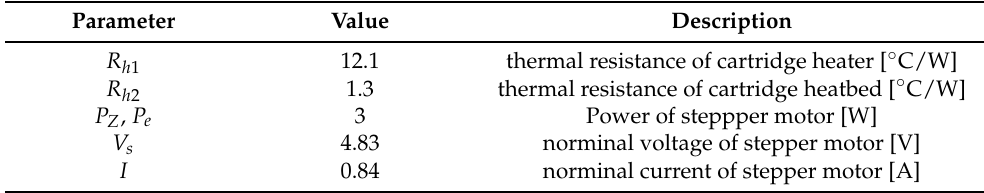
Table 2. Constants and parameters in the